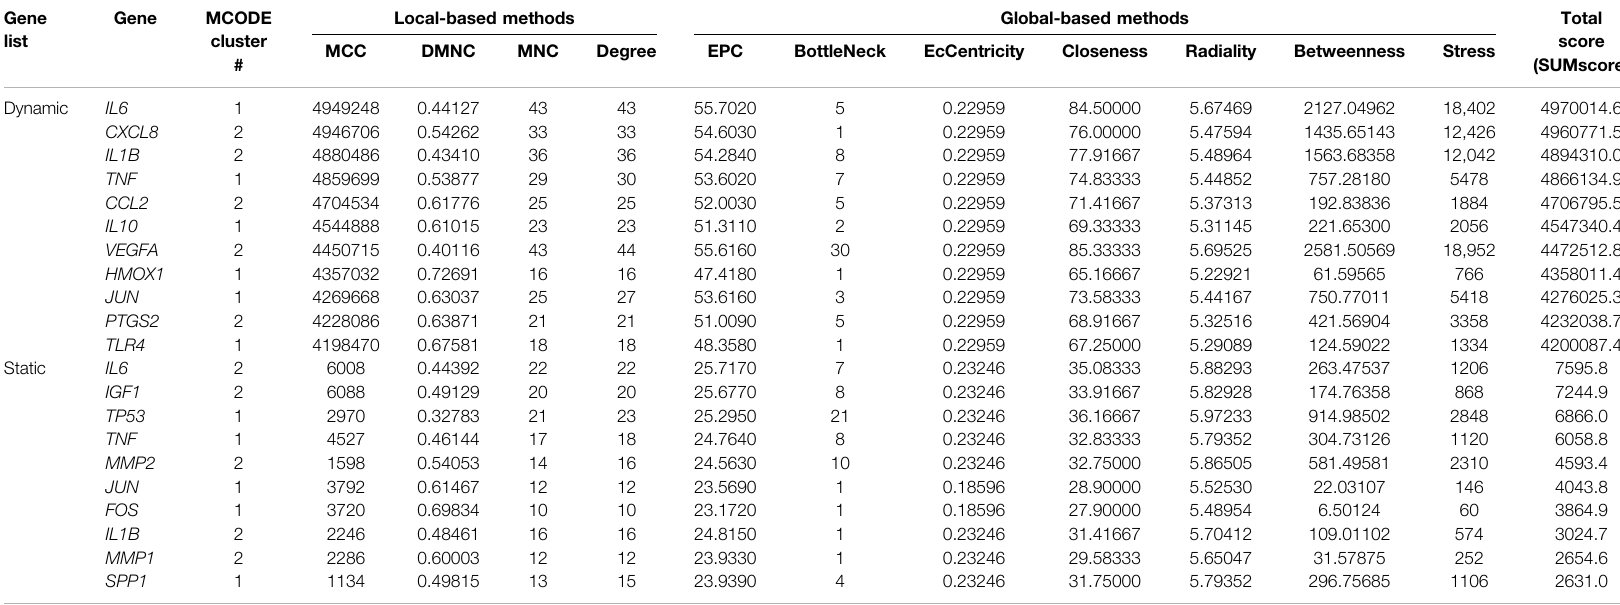
TABLE5| Tophubgenesidenti fi edinbothSTRINGnetworksderivedfromthe “ dynamic ” ( n (cid:1) 147)and “ static ” ( n (cid:1) 57)tensionDEGlists.Differentscoremeasureswerecalculatedby cytoHubba (Chinetal.,2014).Thetotal scorecut-offwassetto ≥ 2*meantotalscoreofeachnetworkbeing361511.0forthe “ dynamic ” networkand1209.0forthe “ static ” network.Inbothliststhehubgenesweresortedindescending orderaccordingtothe total score. These hub genes were colored red in Figure 5